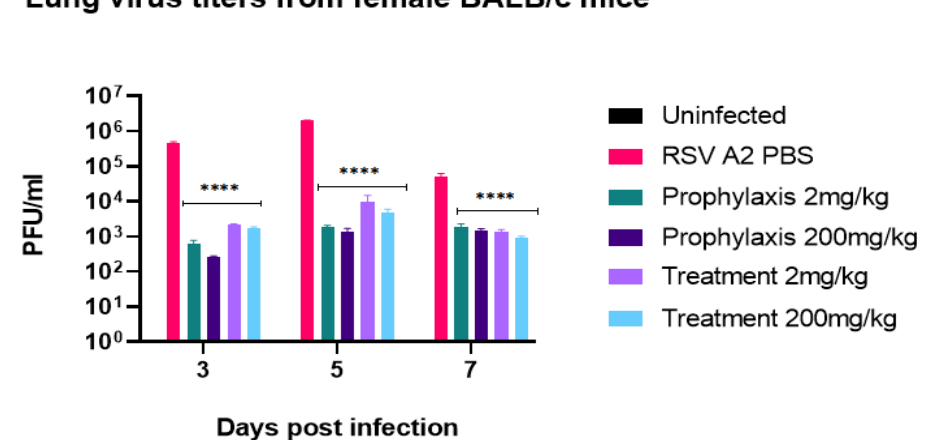
Figure 2. Lung virus titers from female BALB/c mice. The mice received 2 mg/kg or 200 mg/kg probenecid 24 h before infection (prophylaxis) or 24 h pi (treatment). The mice were i.n. infected with 10 6 PFU of RSV A2. On days 3, 5, and 7 pi, the lungs were harvested, and virus titers were determined by plaque assay having a limit of detection of 1 × 10 2 PFU/mL. There is significant (**** p < 0.0001) reduction in lung viral titers with all probenecid treatments compared to control (PBS).